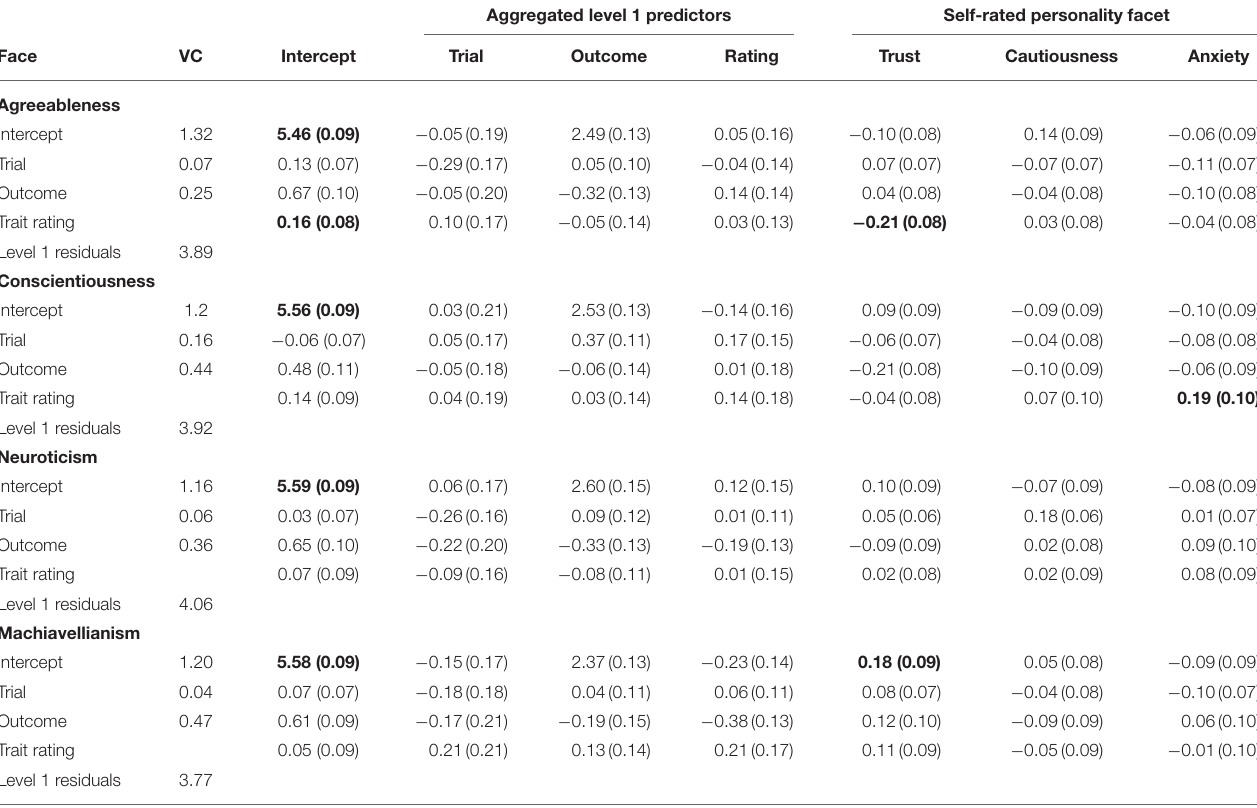
TABLE 1 | Coefficients (robust standard errors) for fixed effects of entrusted amount in the trust